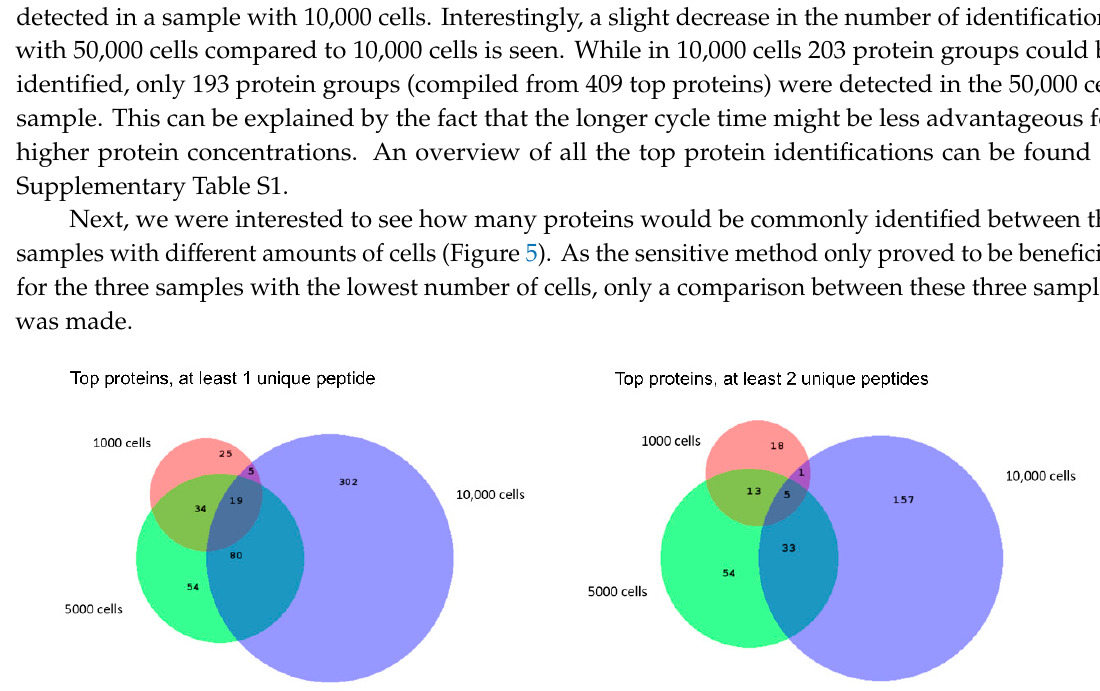
Figure 4. Overview of the number of protein groups, top proteins, proteins, and peptides identified with Peaks X+ in FACS sorted samples on the 1000, 5000, 10,000, and 50,000 cell samples.